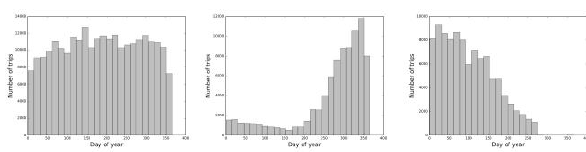
Figure 5. The distribution of trips of Cluster 2, 10 and 14 during the year